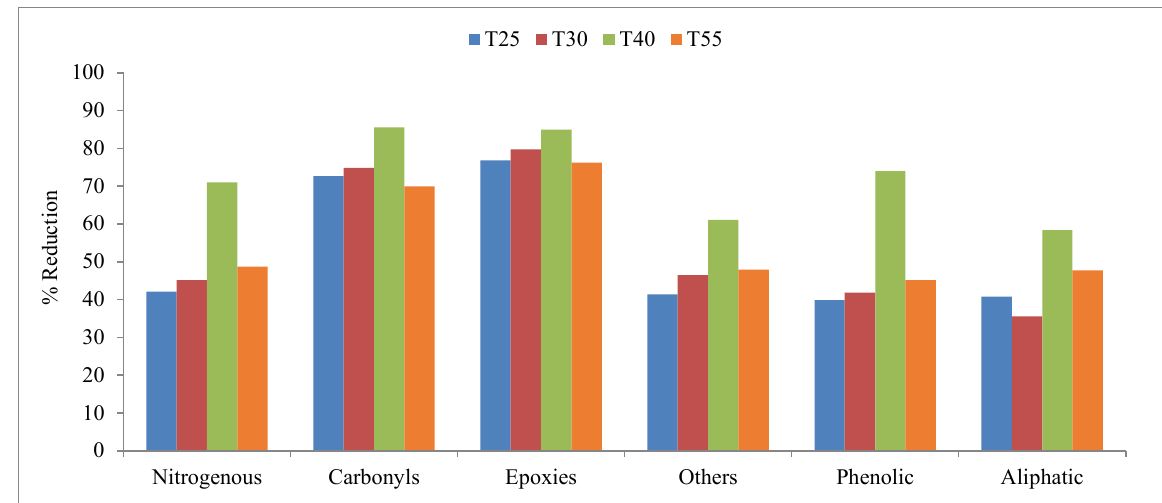
Figure 10. Reduction obtained for the different families of compounds in the total particular matter collected in the study of the temperature (°C) at the first step of the synthesis with fixed conditions of time, 24 h, and stirring rate, 700 rpm.